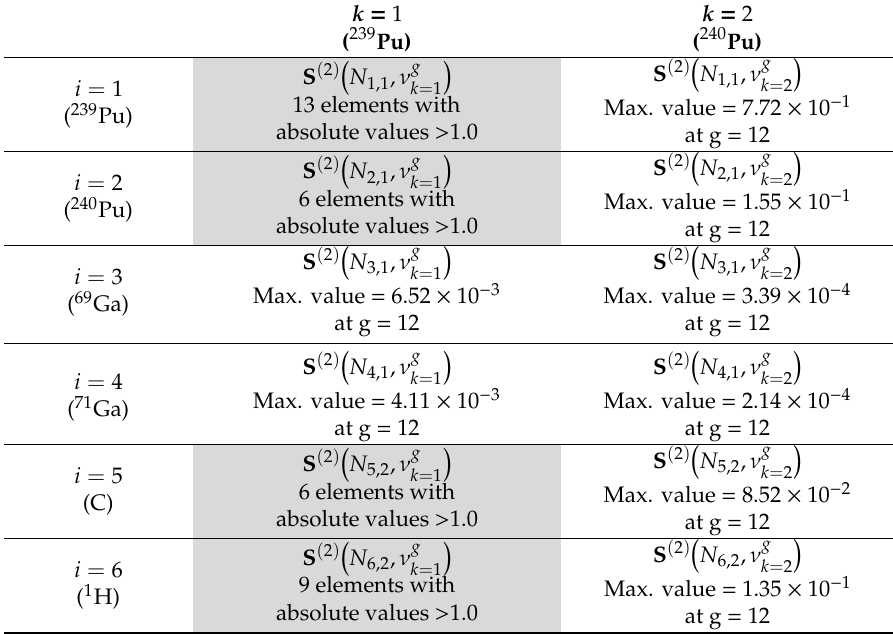
(cid:16) (cid:17) N i , m , ν g , i = 1, ... ,6; k , m = 1,2; g = 1, ... ,30. k